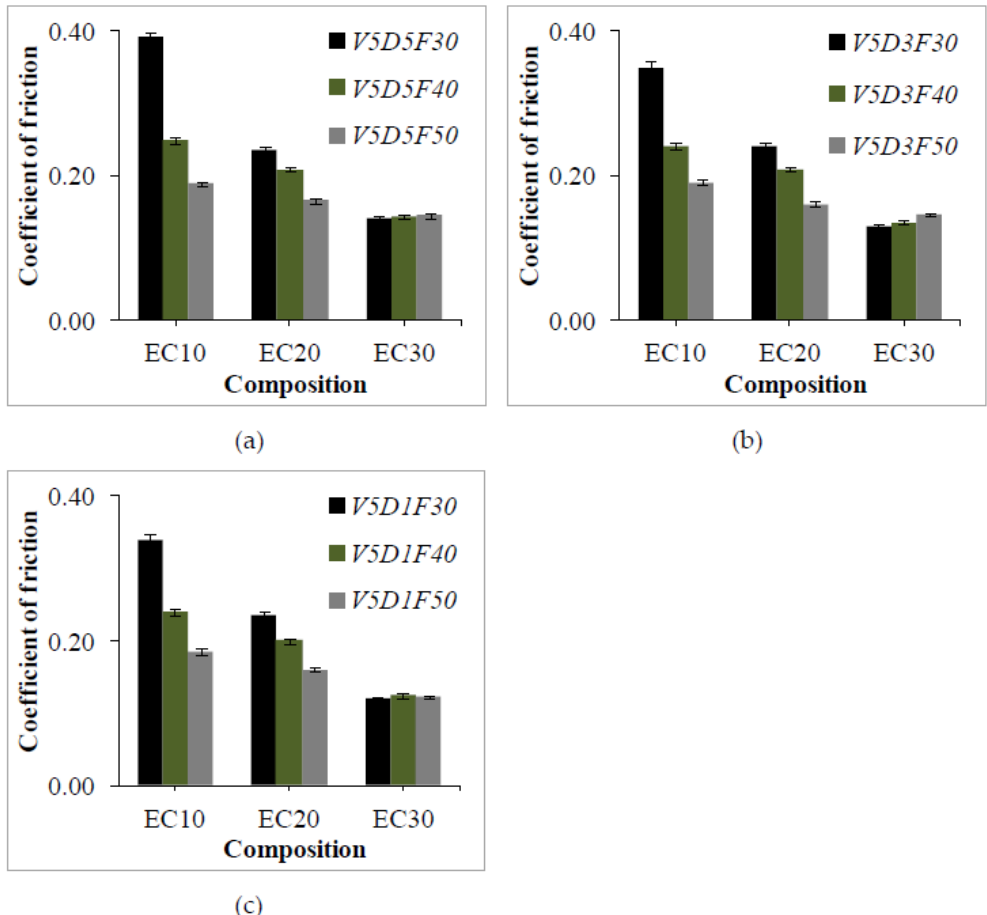
Figure 7. Experimentally measured coefficients of friction at different sliding distances ( a ) 5 km ( b ) 3 km and ( c ) 1 km.